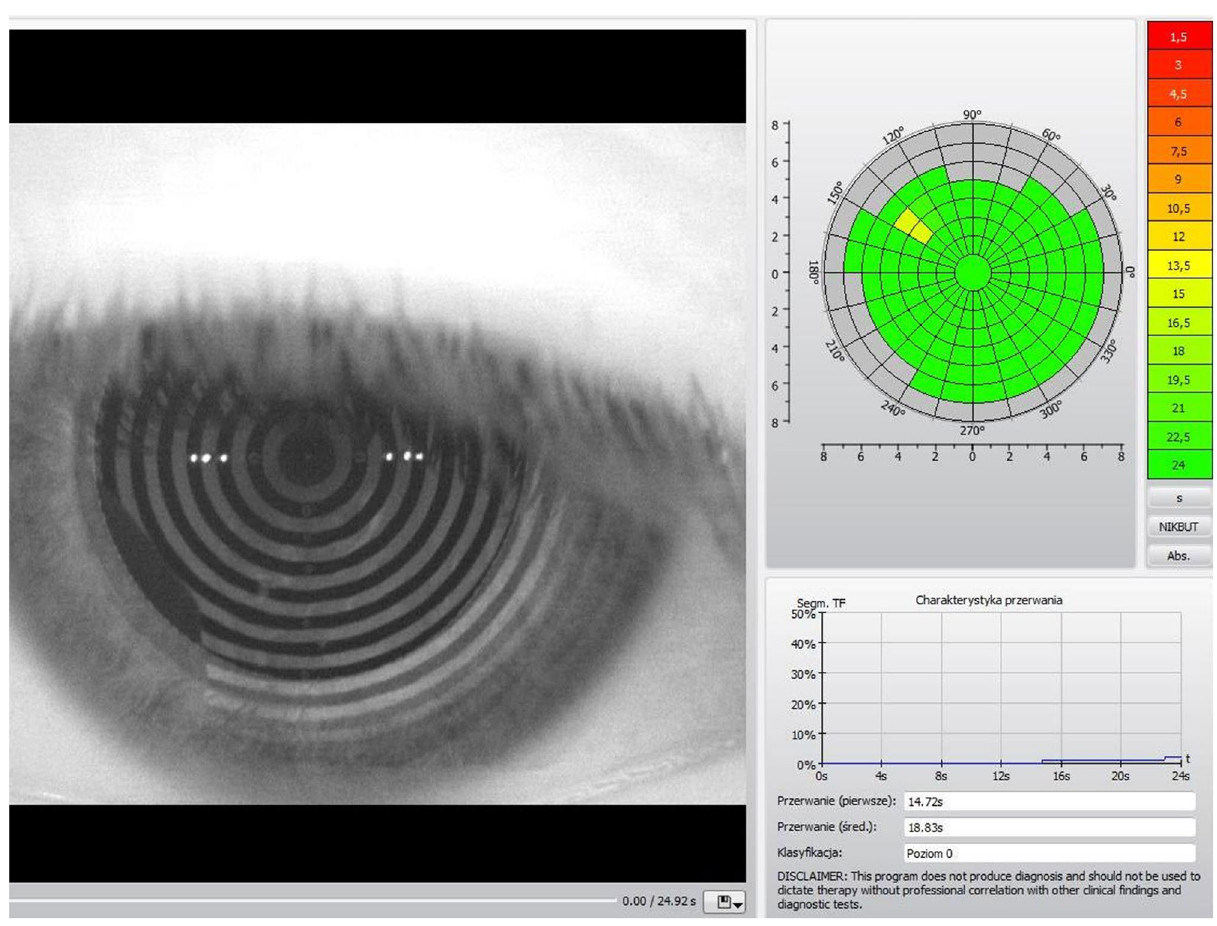
Figure 3. The TearMap by Keratograph 5 M: the respective break up time is graphically illustrated for each segment in seconds—stable tear film (green segments indicate the areas of the stable tear film). Photo: Witold